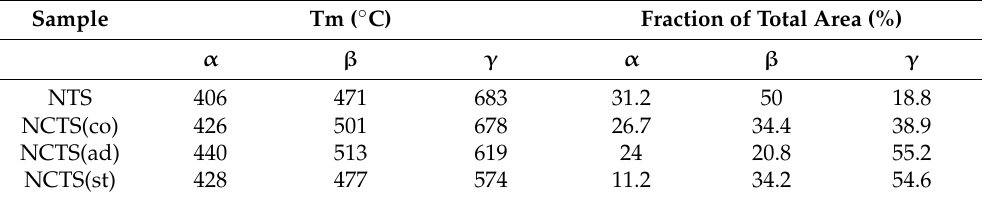
Table 4. TPR data of Ni-based catalysts with and without Ce doping in different steps of impregnation.